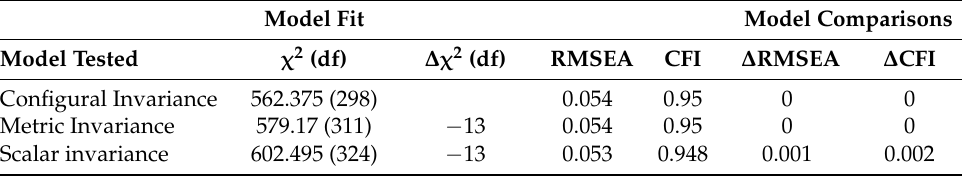
Table 5. Measurement Invariance: Model fit indices and model comparisons. BELOW figures out of line in item